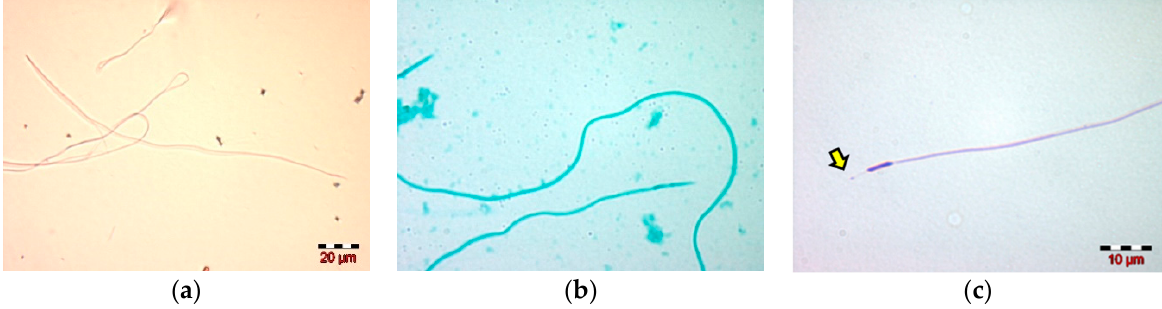
Figure 2. Microscopic images: ( a ) drone spermatozoa stained with Eosin G; ( b ) Spermac; ( c ) Diff-Quik.